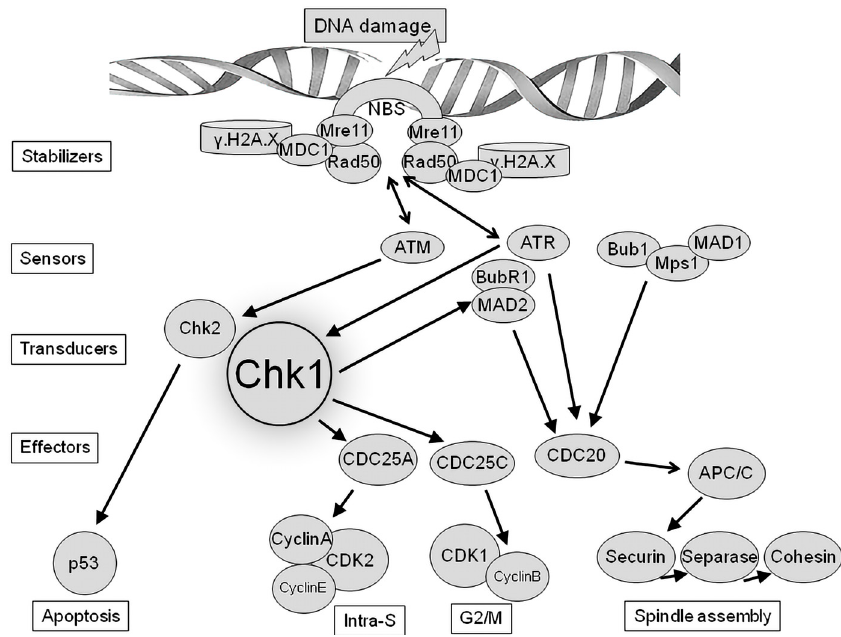
Figure 2. Simplified scheme of the Chk1 interactions in the DNA damage response.